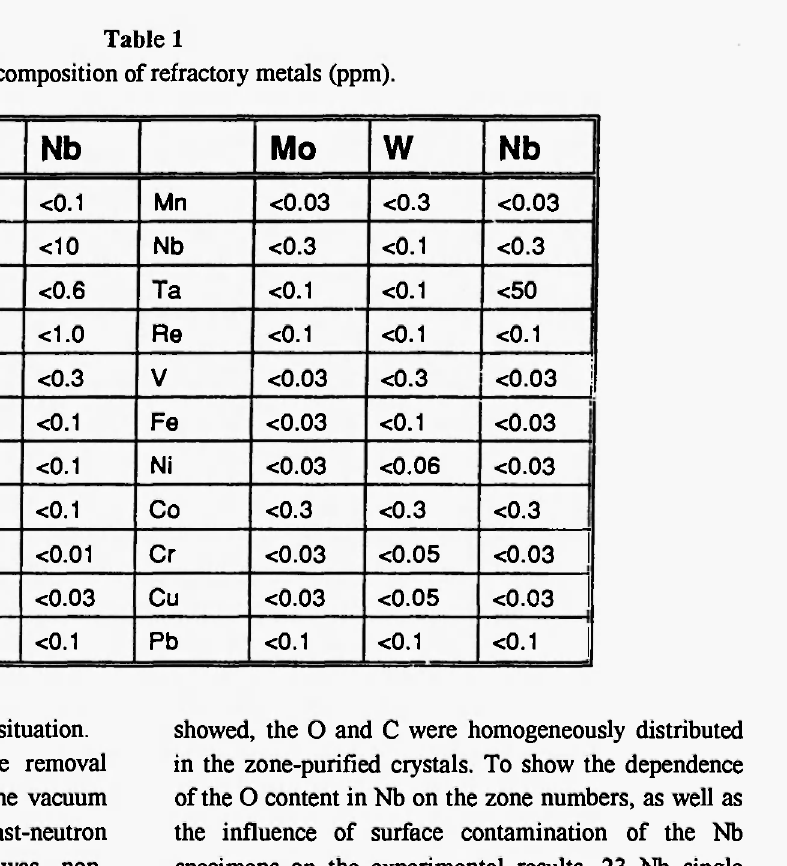
Chemical composition of refractory metals